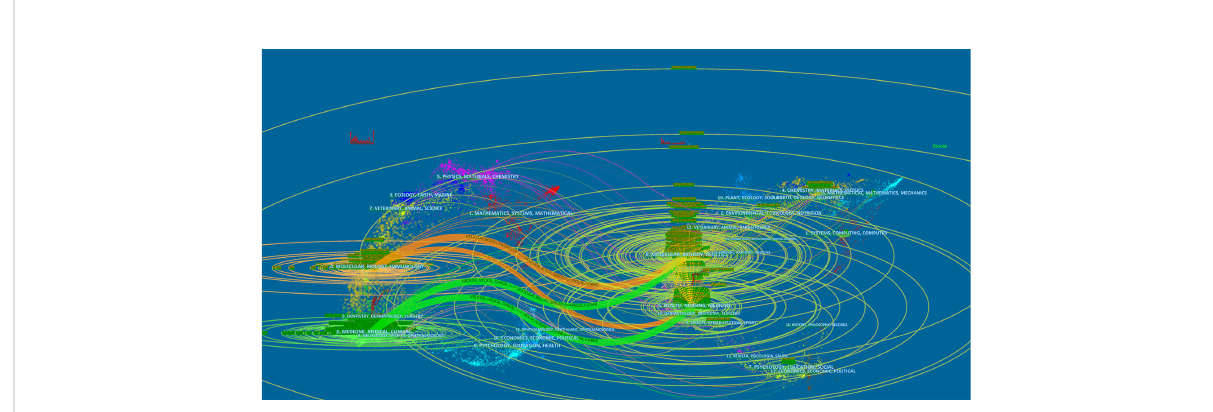
FIGURE 6 A dual map overlap of journals publishing articles on bone metastases in prostate cancer generated by CiteSpace.